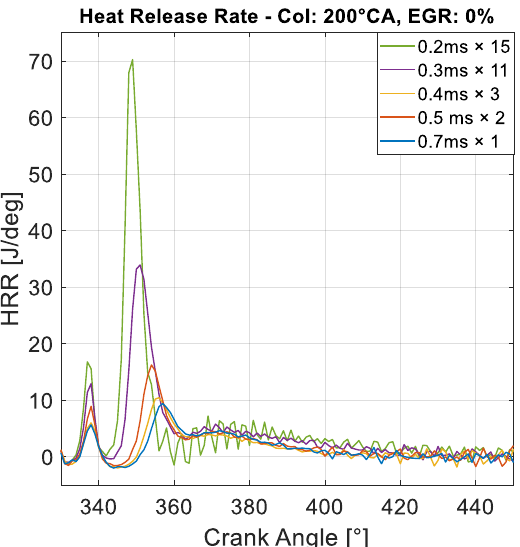
Figure 13. The heat release of the investigated structures with the same dose in the function of crank angle without EGR. The CoI is 200 °CA in each case.